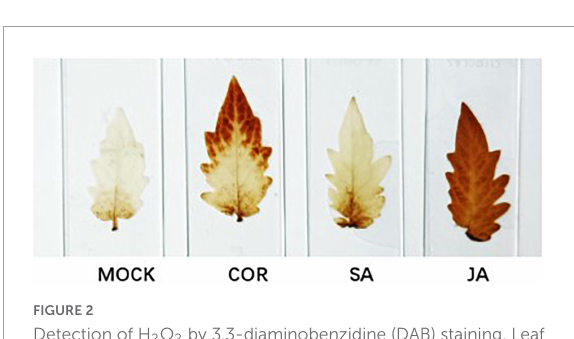
FIGURE2 Detection of H 2 O 2 by 3,3-diaminobenzidine (DAB) staining. Leaf samples were collected 7 days after inoculation with the tomato yellow leaf curl virus (TYLCV) infectious clone that were pre-treated with coronatine (COR), salicylic acid (SA), jasmonate acid (JA), or mock. Brown color in the leaves serves as a proxy for H 2 O 2 production. Shown are representative pictures from three biological